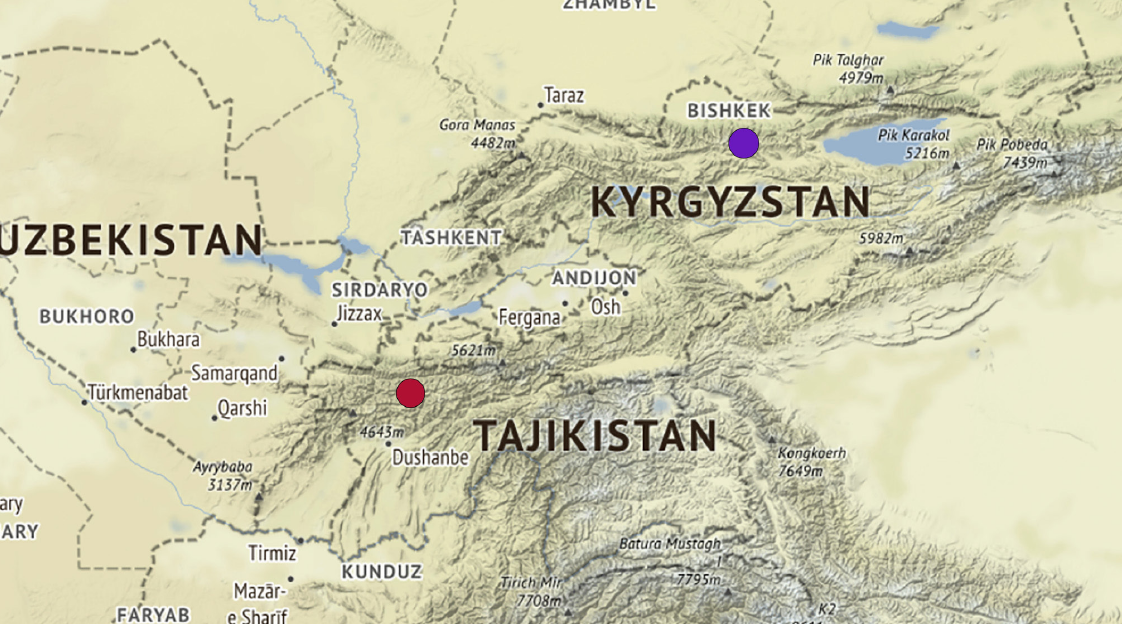
Fig. 2. Distribution map showing the type localities of Quedius gissaricus sp. nov. (red circle) and Q. viator sp. nov. (violet